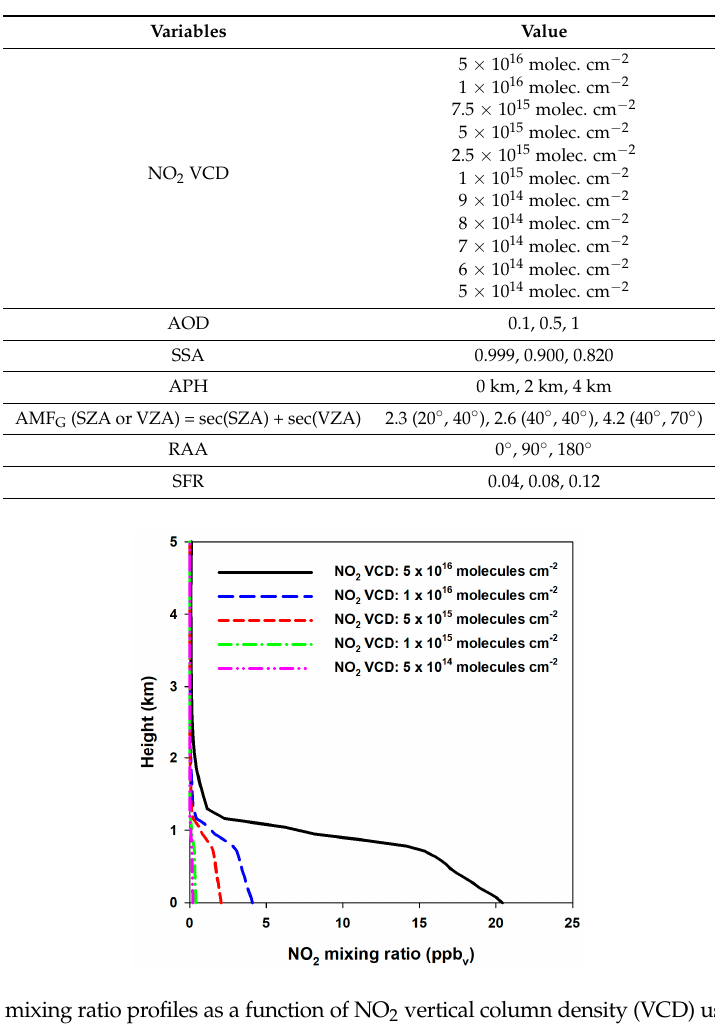
Table 1. Variables used to calculate synthetic radiances and AMF, and their values. (air mass factor (AMF), vertical column density (VCD), aerosol optical depth (AOD), single scattering albedo (SSA), aerosol peak height (APH), solar zenith angle (SZA), viewing zenith angle (VZA), relative azimuth angle (RAA), and surface reflectance (SFR)).